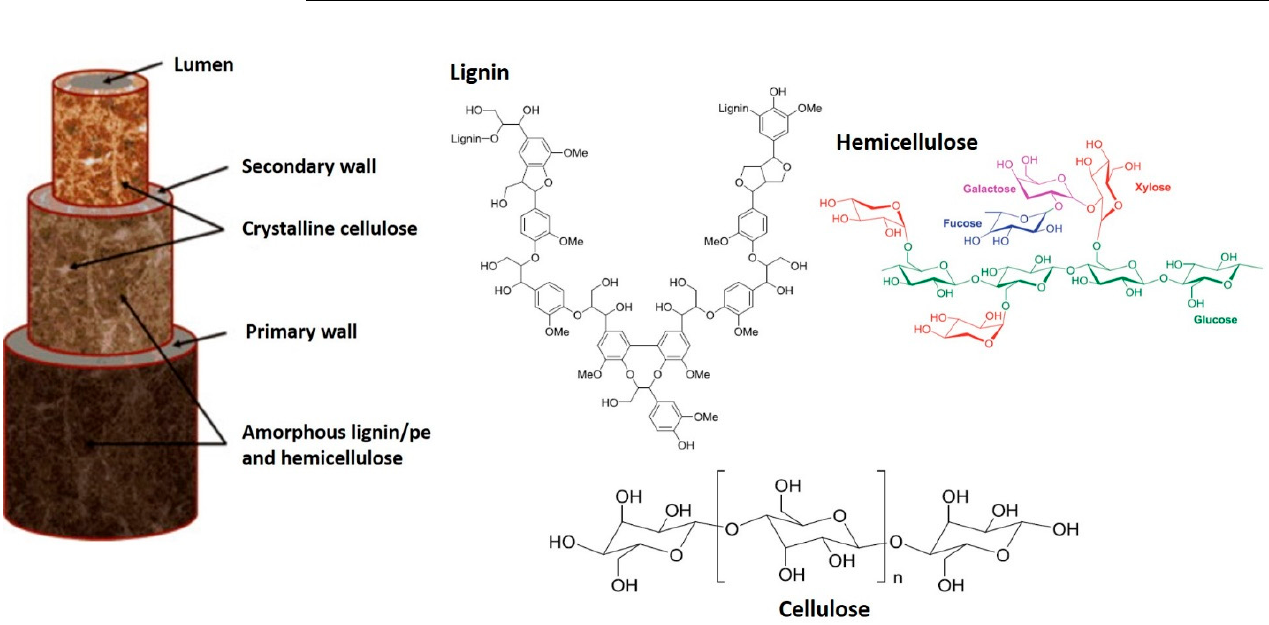
Figure 5. Structure of natural fibers. Table 2. Physical and mechanical performance of natural fiber vs. synthetic fiber.